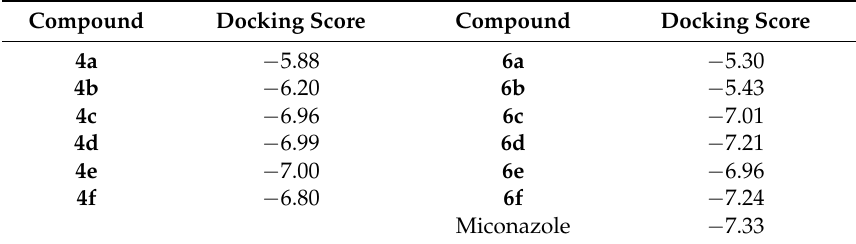
Table 7. The docking scores of the synthesized compounds 4 ( a – f ) and 6 ( a – f ) for cytochrome P450 lanosterol 14 α -demethylase enzyme of C. albicans